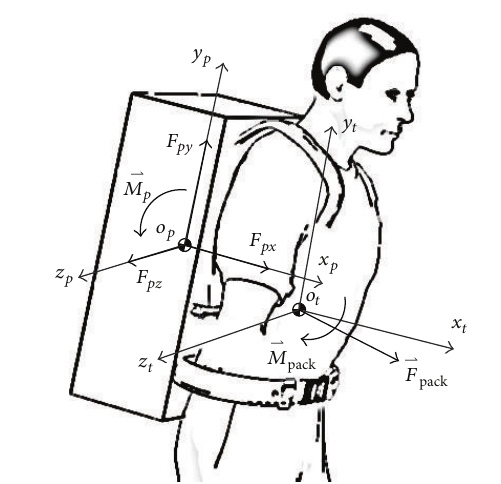
󳨀⇀ 𝐹 𝐹 𝐹 𝐹 𝑝 ( 𝑝𝑥 , 𝑝𝑦 , 𝑝𝑧 ) and Figure 3: The dynamic load carriage test rig. The hydraulic ram drives the mannequin up and down at different frequencies and amplitudes. Accelerometers measure the motion of the backpack and the mannequin, and a load cell measures the dynamic force propelling the